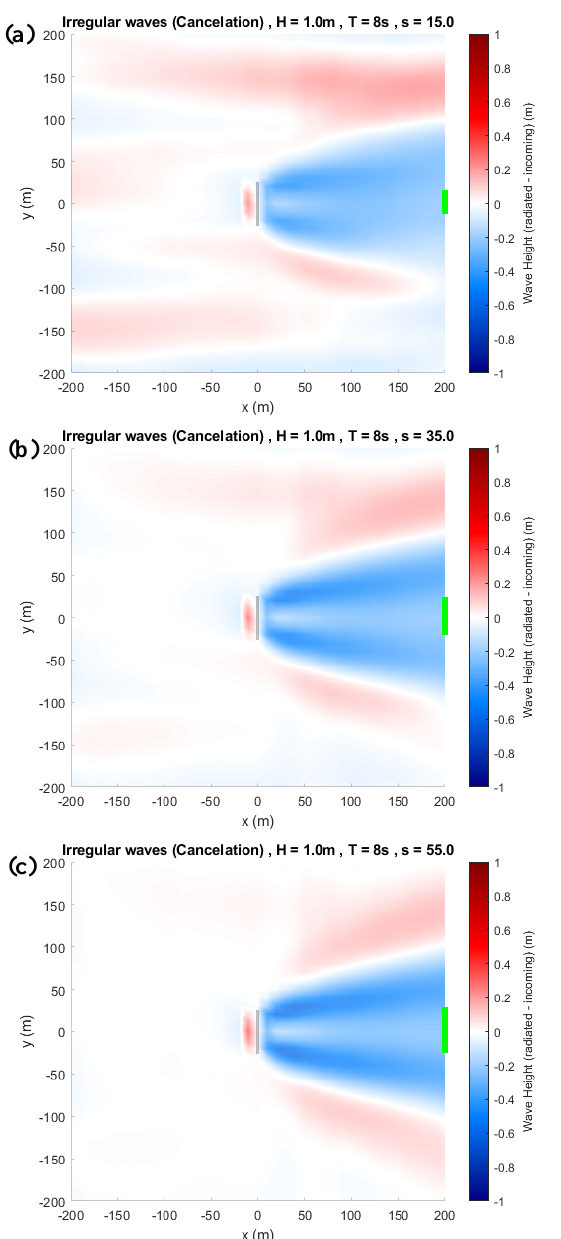
Figure 15: The significant wave height of time averaged wave field for short crested wave conditions for different spreading indexes of, (a) 𝑠𝑖 = 15 , (b) 𝑠𝑖 = 35 , and (c) 𝑠𝑖 = 35 with 𝑠 𝜆 ⁄ = 0.5 . Green solid line represents the capture